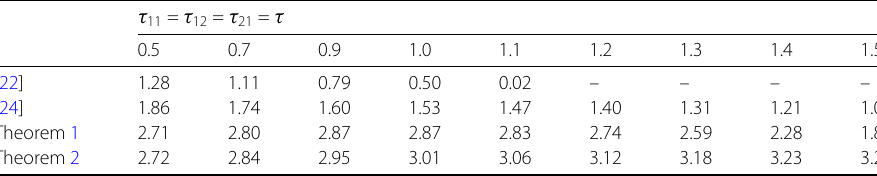
Table 2 Maximum admissible upper bounds of τ 22 for different τ